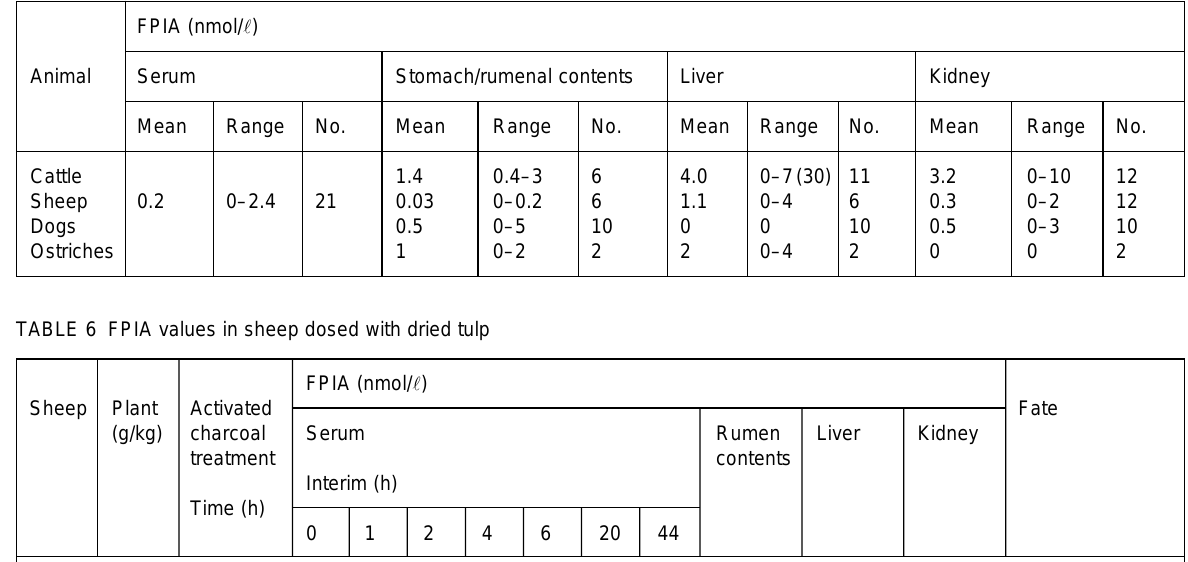
TABLE 5 FPIA values in non-intoxicated animals